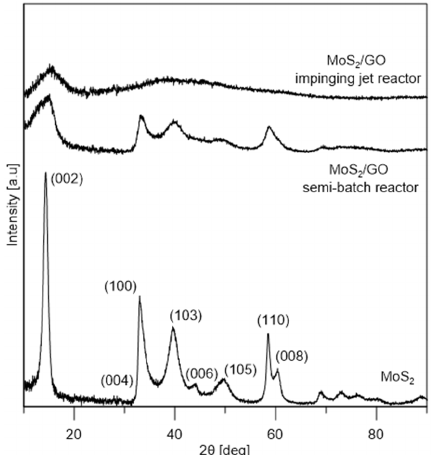
Figure 7. X-ray di ff raction (XRD) patterns of MoS 2 , MoS 2 / GO synthesized in the semi-batch reactor Figure 7. X-ray diffraction (XRD) patterns of MoS 2 , MoS 2 /GO synthesized in the semi-batch reactor and in the impinging jet reactor. and in the impinging jet reactor.